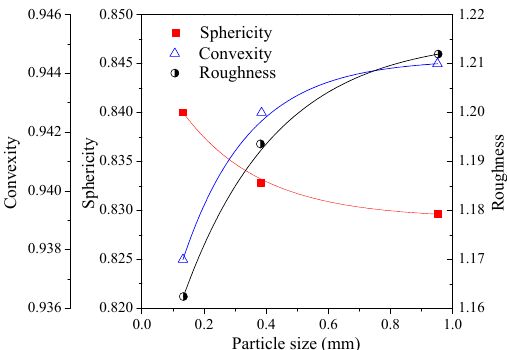
Figure 5. Curve of tailings particle shape parameters.